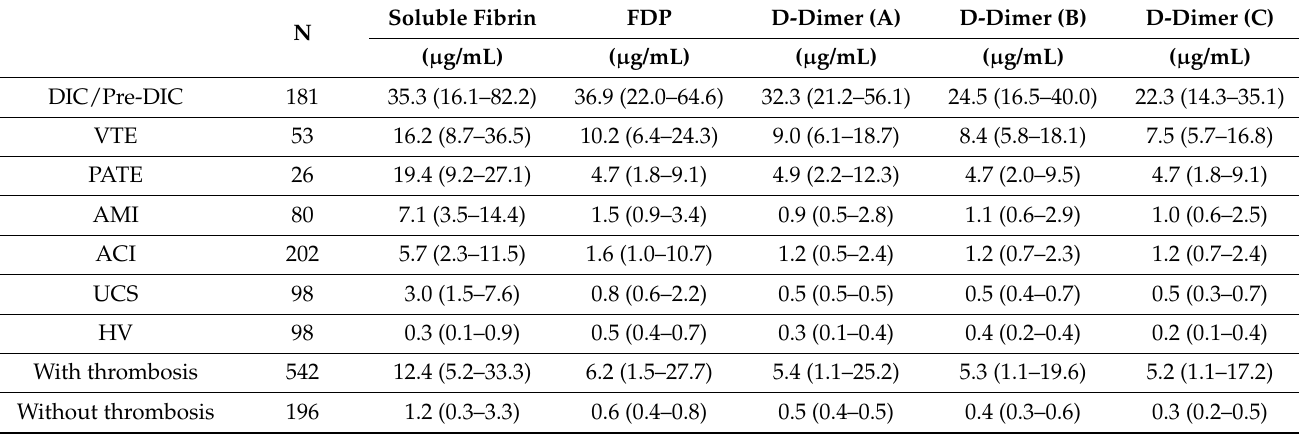
Table 2. D-dimer, soluble fibrin and FDP in DIC, VTE, PATE, AMI, and UCS.